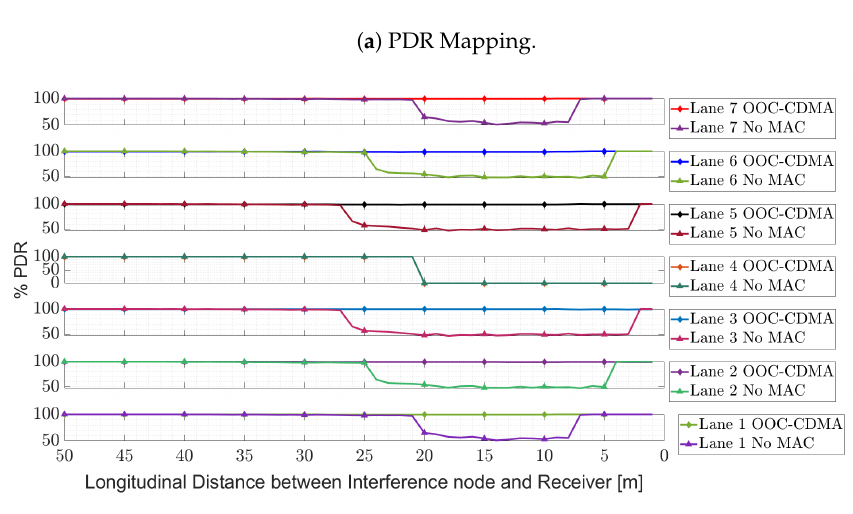
Figure 12. ( a ) PDR performances view from the top in presence of MUI on V2V VLC with OOC- OCDMA MAC, when transmitter and receiver are on the center lane of a seven-lane road at 18 m between them; ( b ) Details for PDR performances.